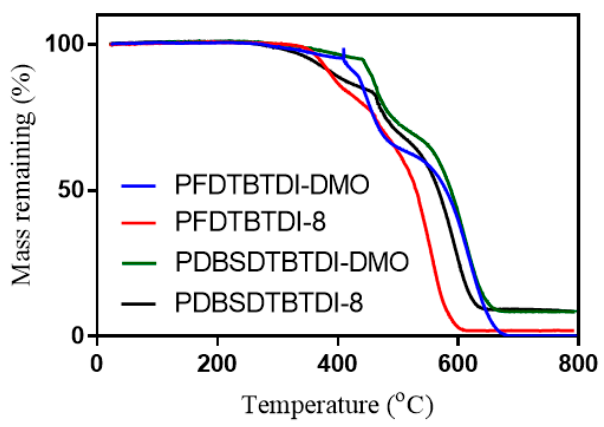
Figure 3. TGA of PFDTBTDI-DMO, PFDTBTDI-8, PDBSDTBTDI-DMO, and PDBSDTBTDI-8.